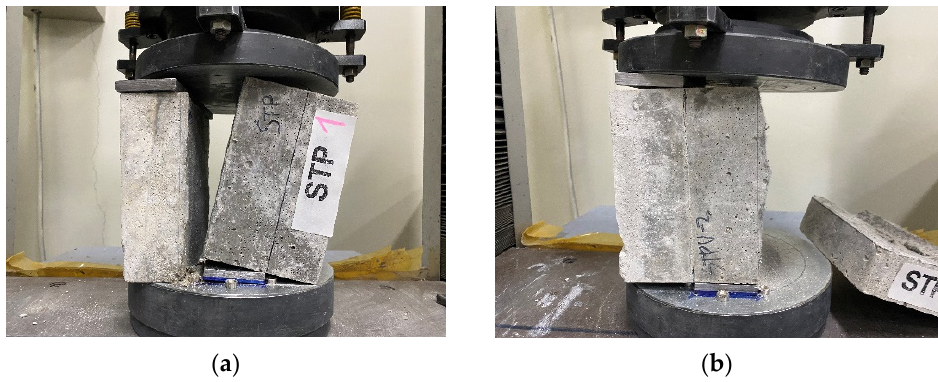
Figure 5. Failure modes of specimens: ( a ) interfacial failure (STP); ( b ) substrate failure (STPU-2). The average bond strength of the STUP-1 and STUP-2 specimens (the mortar with non- dispersive, anti-washout grouts) is evaluated as 4.8 MPa and 10.2 MPa, respectively. Bond failure occurs at the mortar–grout interface for the STPU-1 specimens. On the other hand, two of the STPU-2 series specimens fail at the mortar–grout interface, while one specimen (STPU-2-2, Figure 5b) experiences shear failure of the mortar substrate. Note that the tested value for the STPU-2-2 specimen is 11.1 MPa, and this value is considered to be the shear strength of the mortar, rather than the bond strength between the mortar and